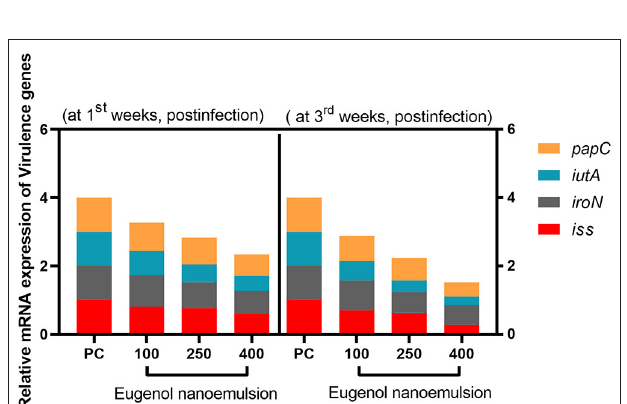
FIGURE 7 | RT-qPCR investigation of the relative mRNA expression levels of E. coli papC , iutA , iroN, and iss virulence genes in the cecal contents of broiler chickens fed different levels of eugenol nanoemulsion at the 1st- and 3rd-week post-challenges. Values are means with their SE. NC (negative control): birds fed basal diet without eugenol nanoemulsion and were not challenged, PC (positive control): birds fed a control diet without eugenol nanoemulsion and were challenged, eugenol nanoemulsion 100, 250, and 400: birds fed basal diet supplemented with 100, 250, and 400 mg/kg diet eugenol nanoemulsion. All groups except NC were challenged with E. coli O78 at 14 days of